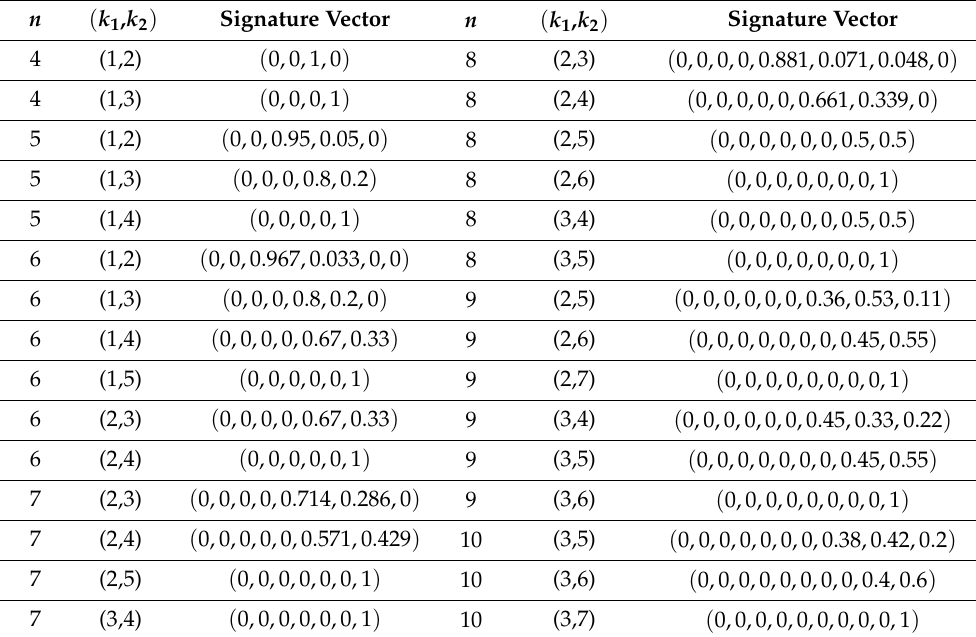
Table 2. Signature vector of consecutive- k 1 and k 2 -out-of- n systems for di ff erent